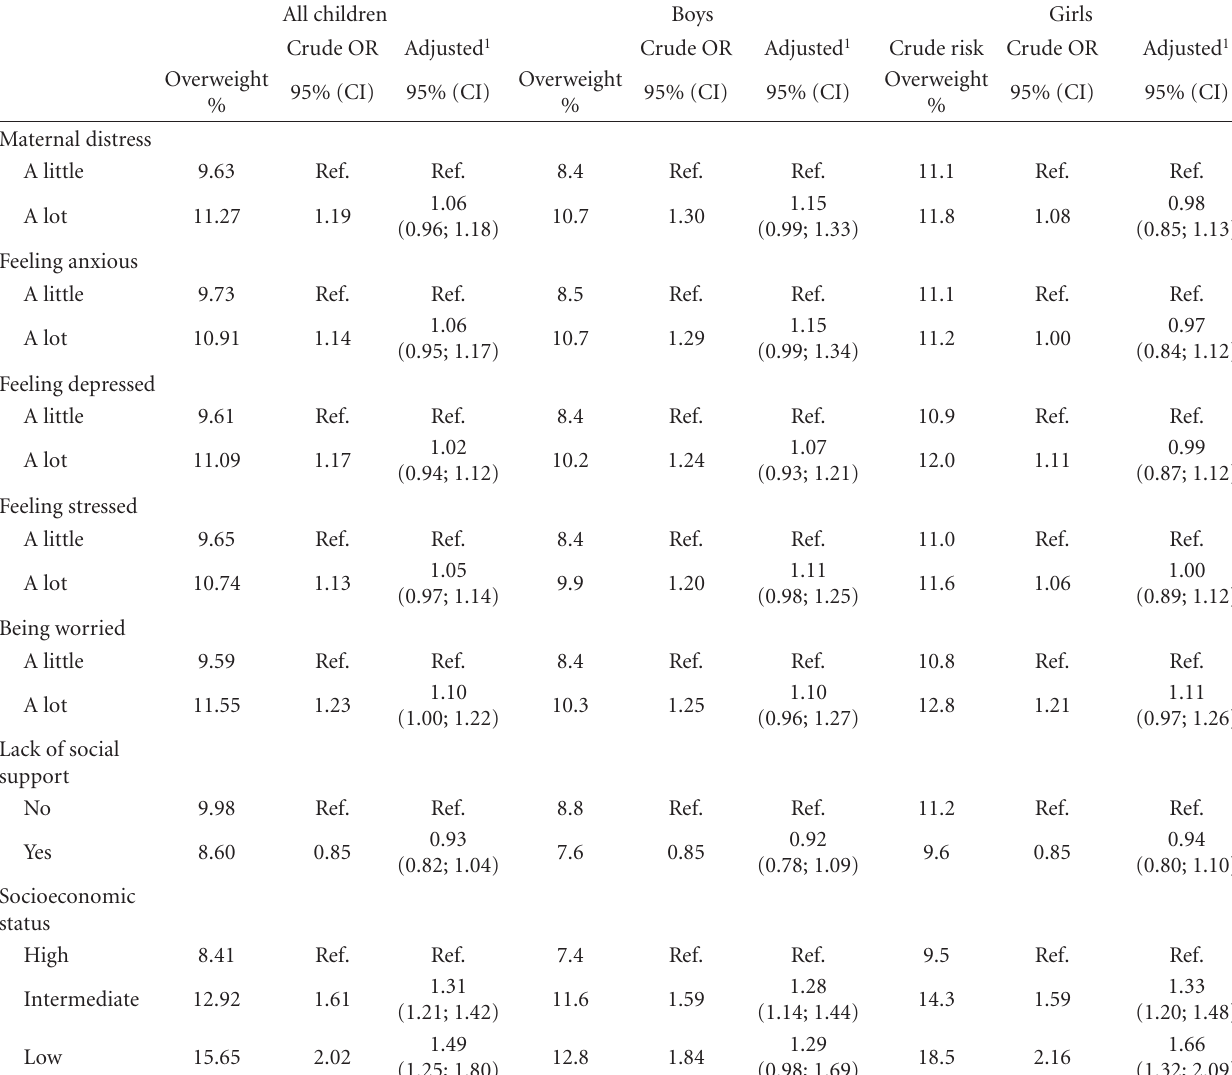
Table 3: Maternal distress during pregnancy and risk of childhood overweight at age